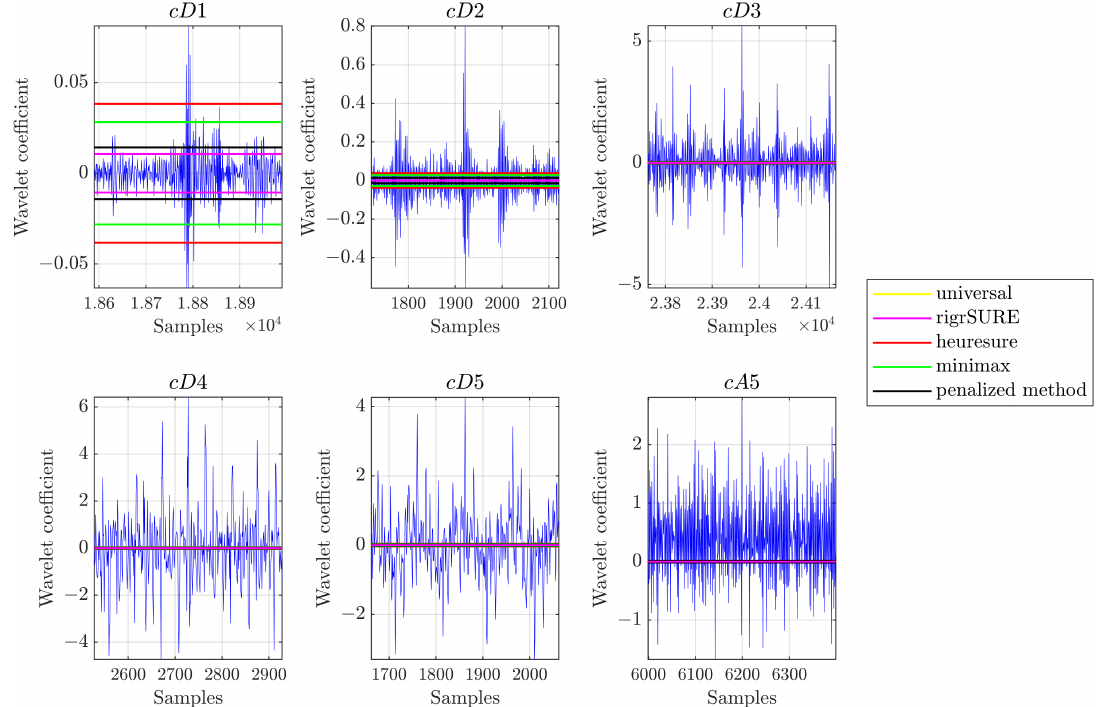
Figure 3. Example of threshold application on wavelet coefficients of signals from rolling